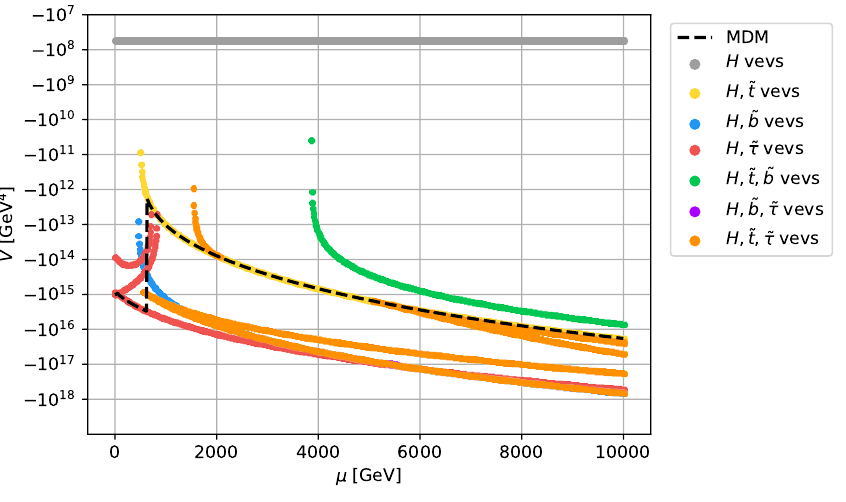
Figure 10 . Depth of the di(cid:11)erent types of stationary points along the line of constant X t = 5 TeV from (cid:12)gure 9. The colour code indicates which (cid:12)elds have non-zero vevs at the stationary point. The dashed line indicates which of the stationary points is the MDM. The EW vacuum is shown in